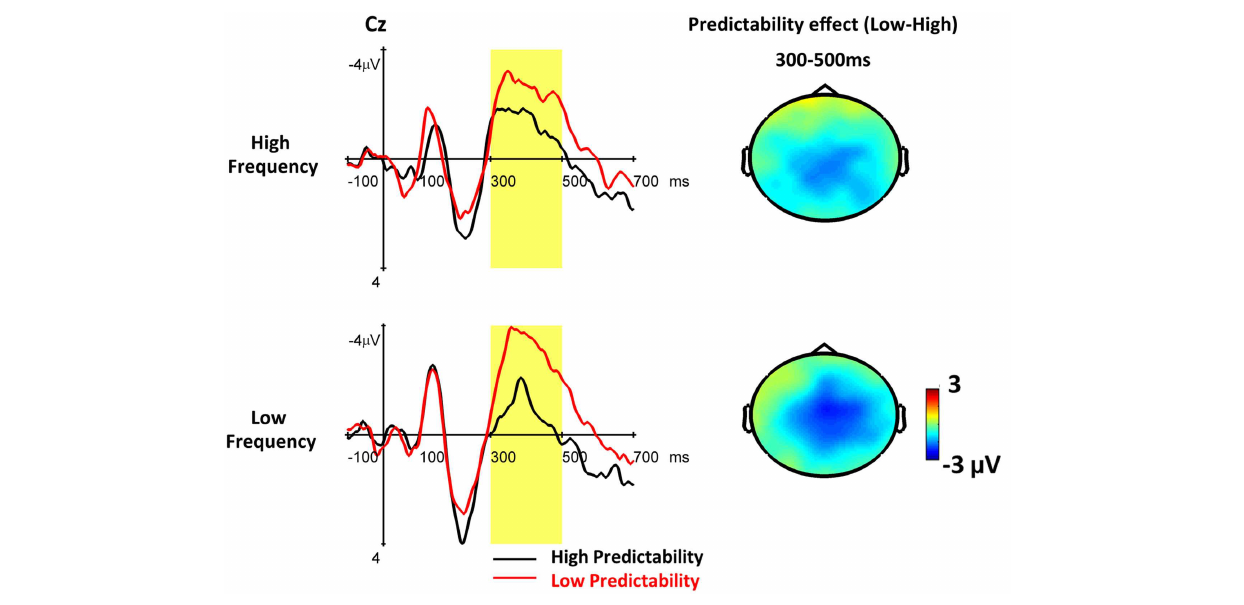
window (300–500ms) of the N400.The topographic maps show the predictability effects (low minus high) for high and low frequency words,